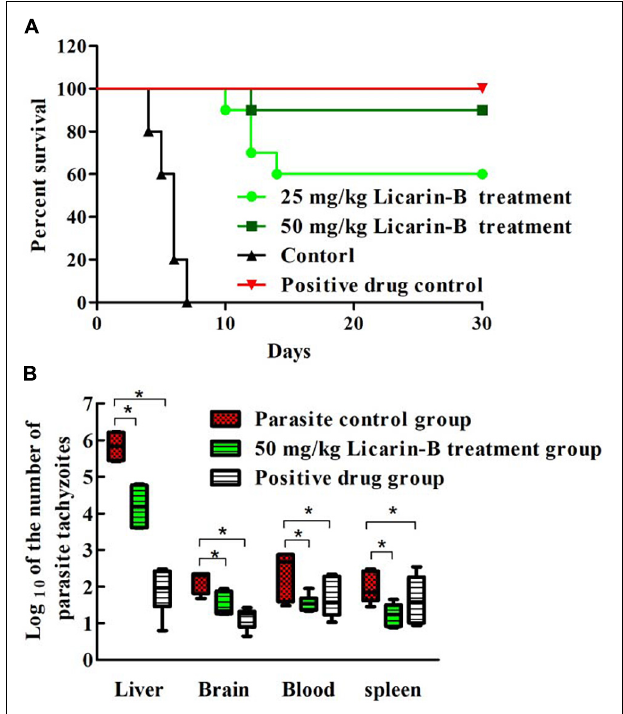
FIGURE 3 | Effect of licarin-B on the survival rate of acutely infected mice (A) . All the mice were infected with T. gondii tachyzoites and then treated with licarin-B (25 or 50 mg/kg · bw), a positive control drug PBS once daily for 15 days. The mice were then observed for an additional 15 days, and the survival times of the infected mice were recorded for 30 days. Licarin-B treatment reduced the parasite burden in blood or tissues from the acutely infected mice (B) . The mice were challenged intraperitoneally with T. gondii tachyzoites and then treated with licarin-B or PBS once daily for 7 days. The parasite loads in the blood and brain, liver, and spleen tissues of the infected BALB/c mice were isolated and homogenized. Total genomic DNA was isolated, and the T. gondii 529-bp gene was detected by qPCR. The quantified parasite loads in the tissues and blood of mice are presented as the log10 values of the numbers of tachyzoites per 20 mg of tissue or 50 µ L of blood. * p < 0.01 compared with the parasite